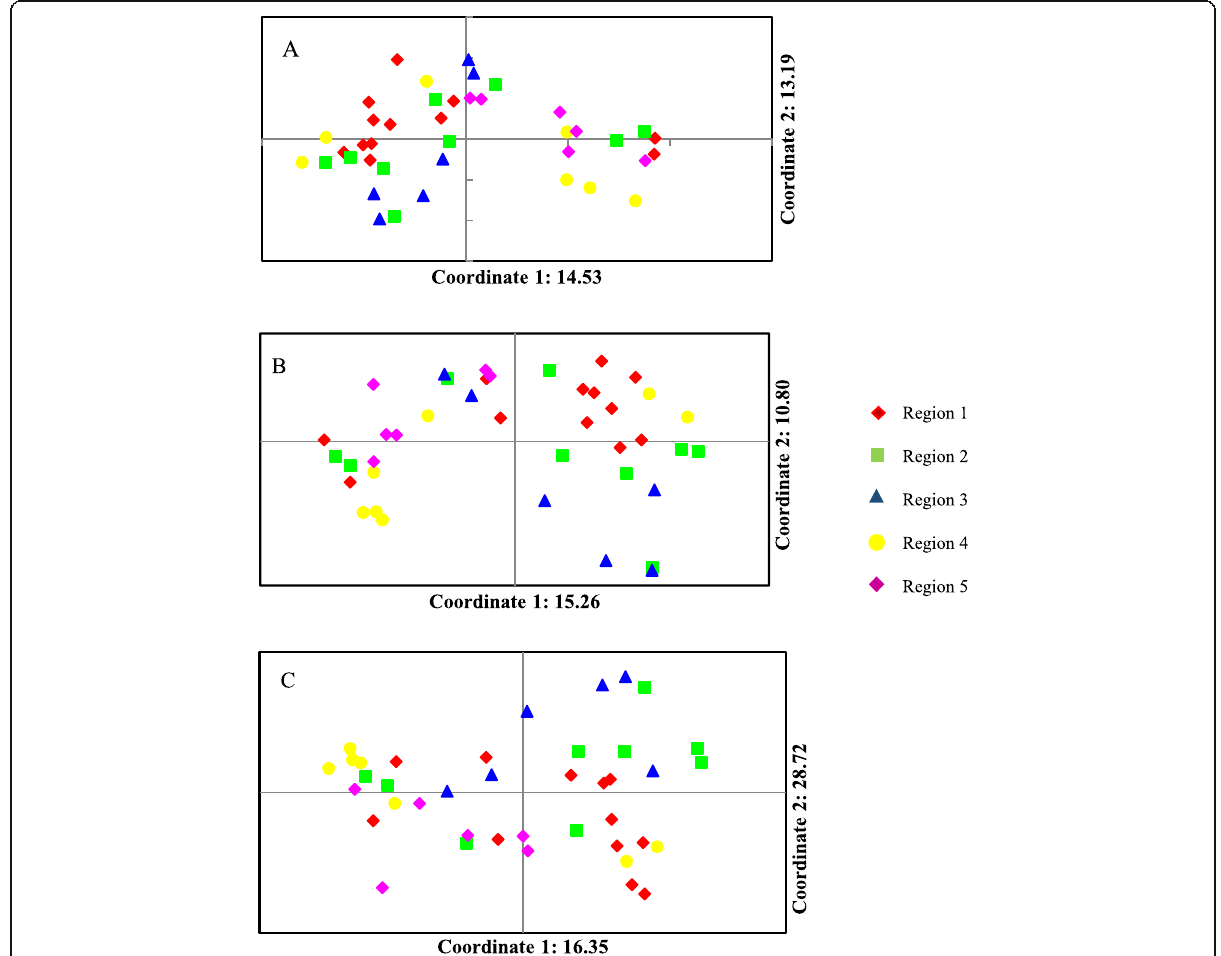
Fig. 3 Principal coordinate analyses (PCoA) for 40 Iranian Rosa damascena accessions based on URP ( A ), SCoT ( B ), and SCoT URP ( C )